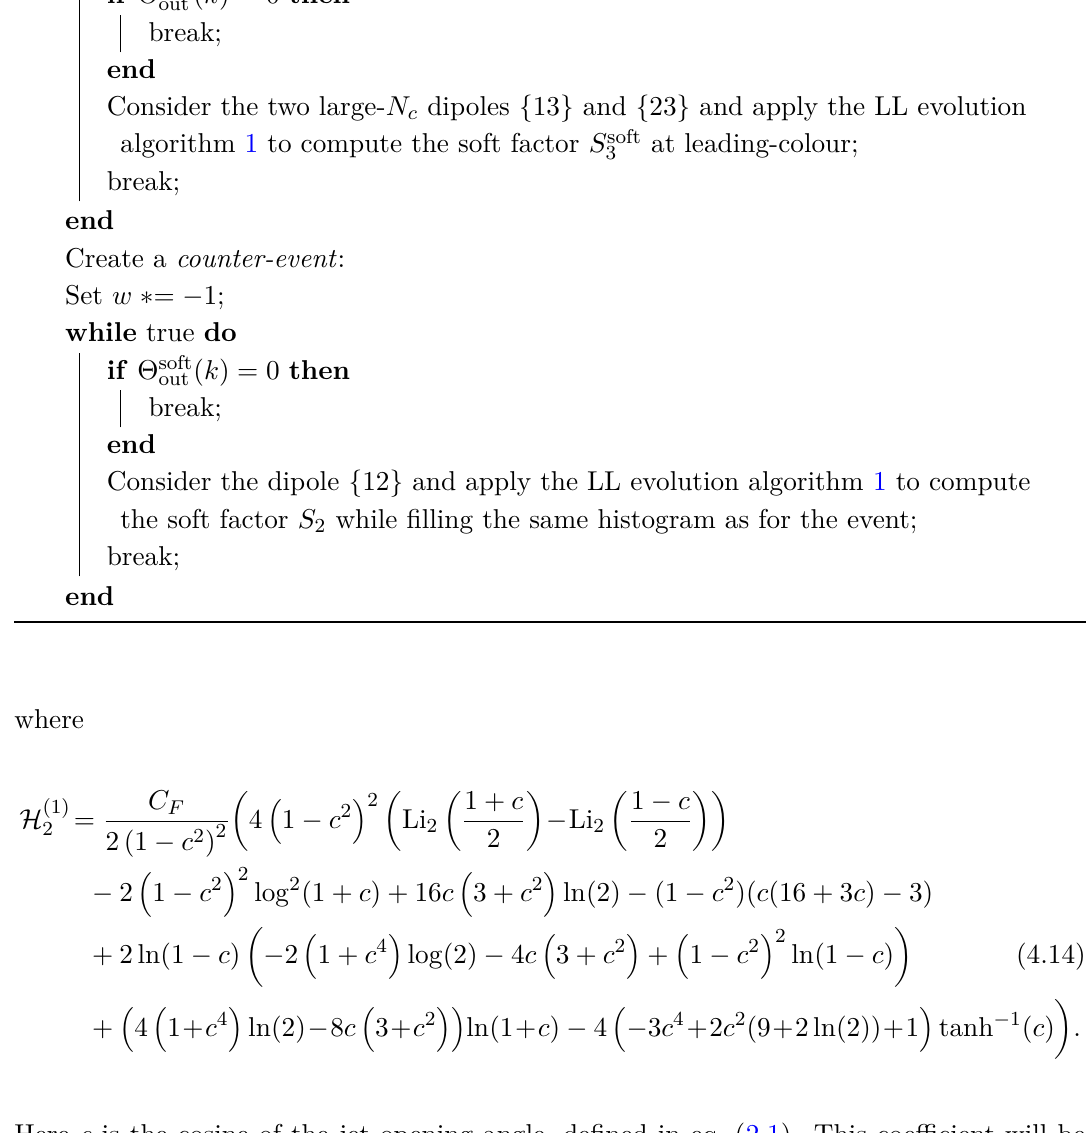
algorithm 1 to compute the soft factor S soft